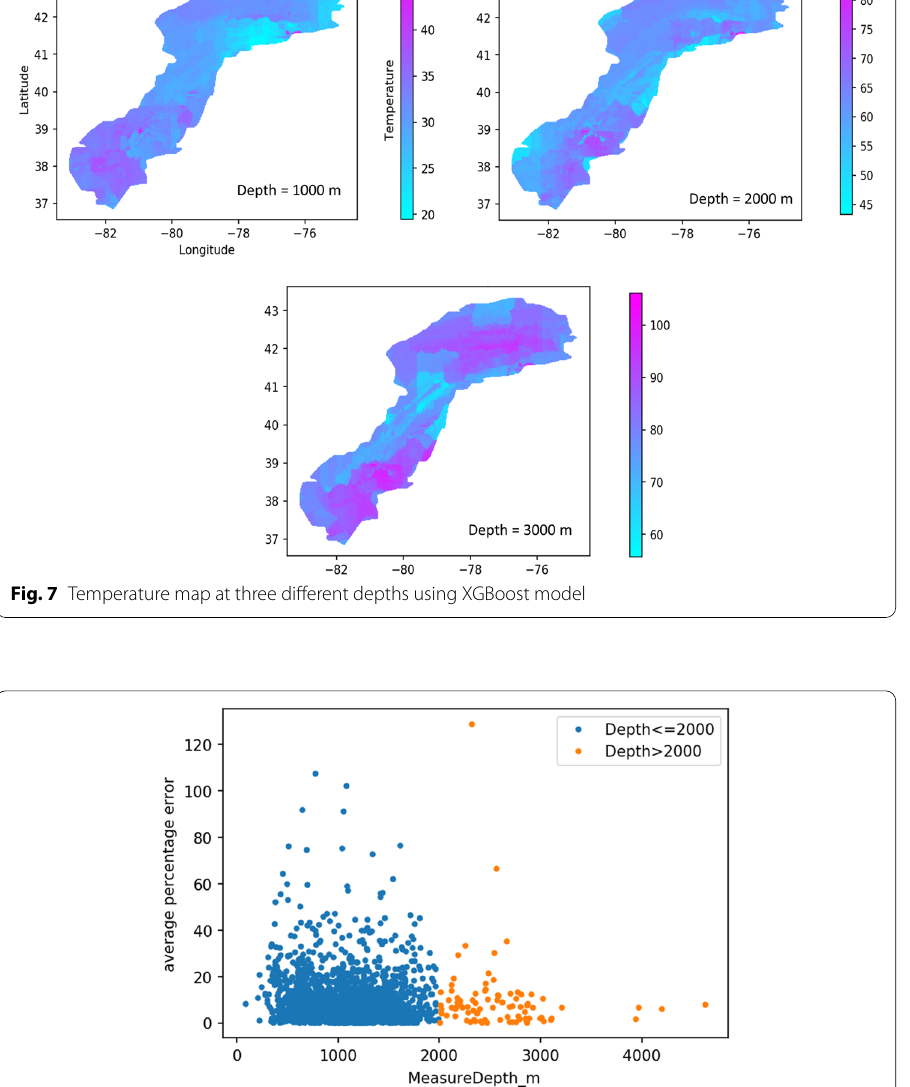
Fig. 8 Average percentage error calculated using XGBoost predictions and true BHT values for well-represented and underrepresented test data. In this instance, MAPE of blue and orange points are 9.17 and 10.05%,